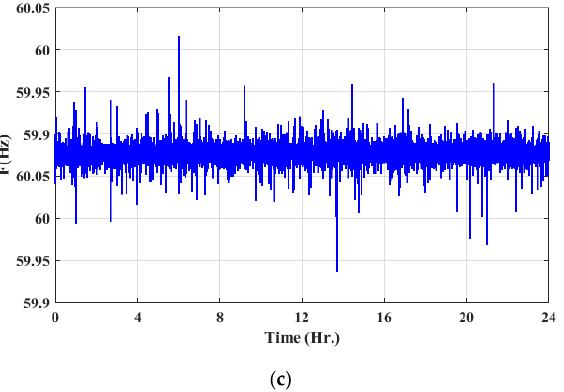
Figure 16. Frequency response for the MG; ( a ) without any compensations, ( b ) with V2G compen- sations, and ( c ) with DSTATCOM and V2G compensations.